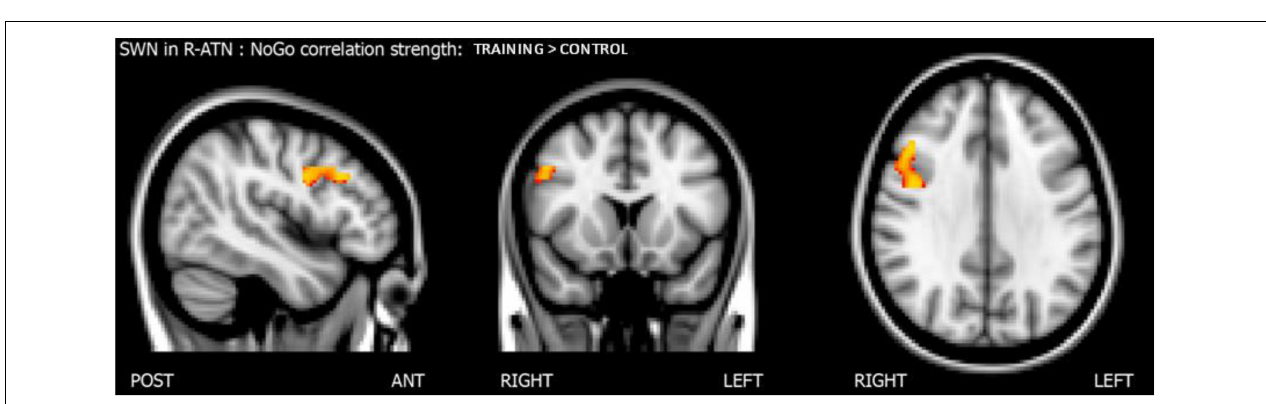
FIGURE 4 | Results of the score-within-network (SWN) analysis within R-ATN: group × nogo hits interaction.